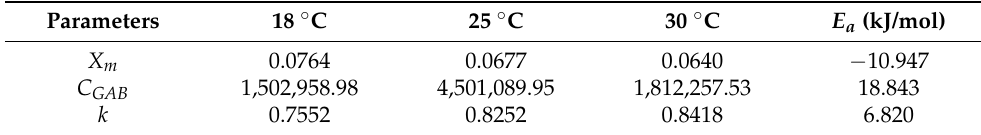
Table 4. Activation energy of the GAB isotherm